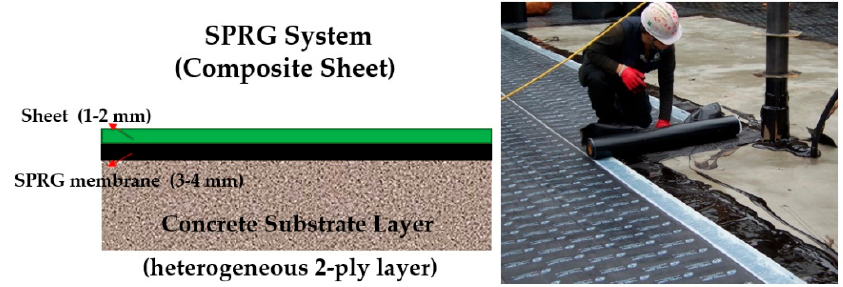
Figure 2. Separate and integrated 2-ply type SPRG waterproofing systems.